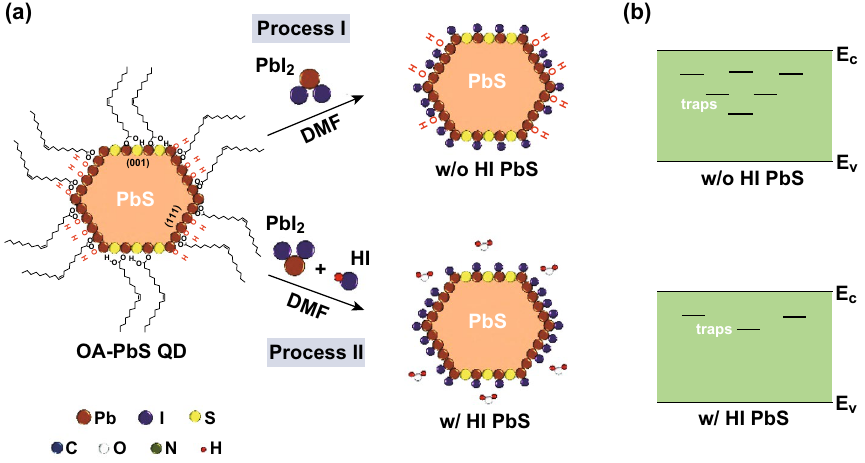
Fig. 1 a A schematic description of the solution‑ligand exchange of PbI 2 treated PbS‑QDs (Process I) and HI‑PbI 2 treated PbS‑QDs (Process II). b Corresponding trap level evolution of PbS‑QDs treated by PbI 2 and HI‑PbI 2